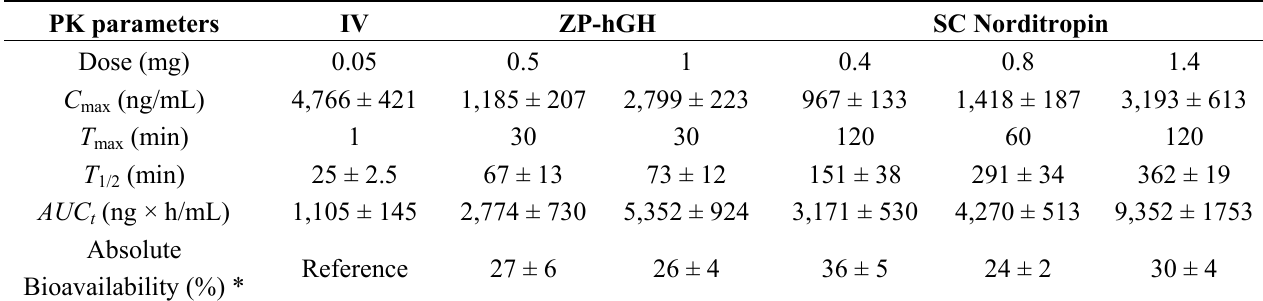
Table 1. Comparison of PK parameters for intravenous (IV), ZP-hGH and Norditropin ® SC Injection. PK